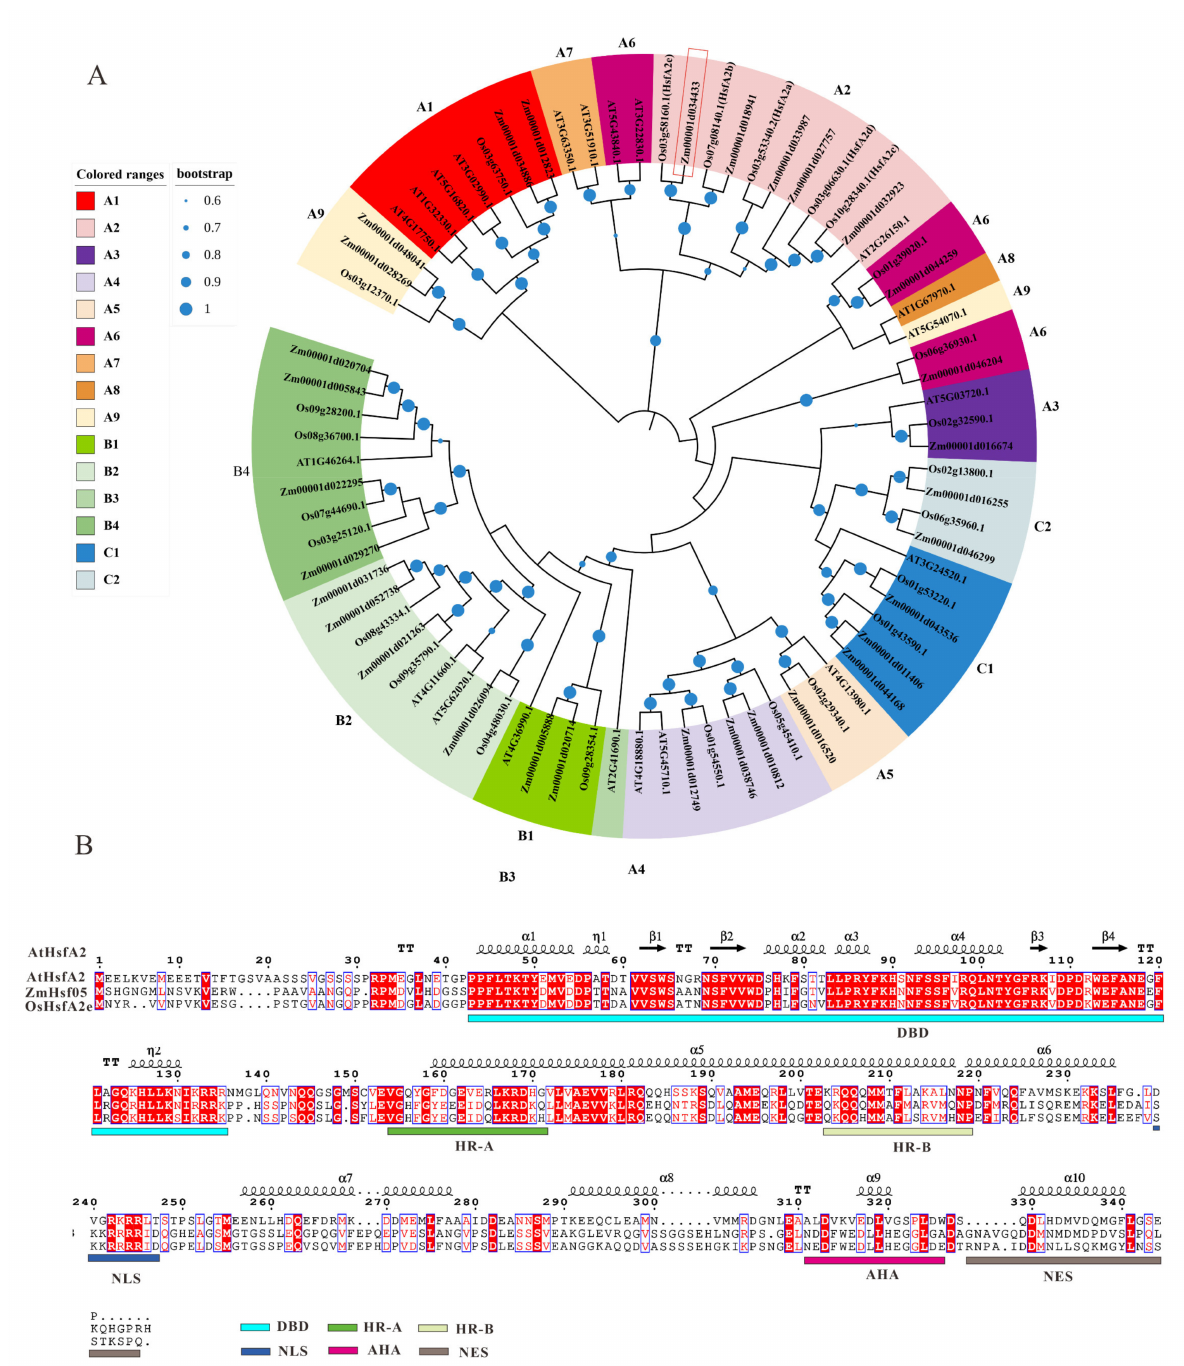
Figure 1. Homologous analysis of heat shock transcription factor 05 (ZmHsf05) with Hsfs in maize ( Zea mays ), rice ( Oryza sativa ) and Arabidopsis thaliana . ( A ) The phylogenetic tree was constructed using the neighbor-joining method. Heat shock transcription factors (Hsfs) were classified into different sub-classes according to their annotation in the Uniprot website and marked with a different color. Nodes with bootstrap values larger than 0.6 are shown by blue circles. ZmHsf05 is emphasized by a red box. Zm, Os, and AT is short for maize, rice and Arabidopsis thaliana, respectively. ( B ) Multiple sequences alignments of ZmHsf05, AtHsfA2 and OsHsfA2e. Identical and similar residues are boxed in red and white, respectively. Domain composition and position were marked with colored boxes below the alignments (DBD, DNA binding domain; OD, oligomerization domain, NLS, nuclear localization signal; AHA, aromatics hydrophobic and acidic amino acid residues; NES, nuclear export signal). The predicted second structure of AtHsfA2 was present above the alignments (helix, squiggles, β -strands, arrows; turns, TT